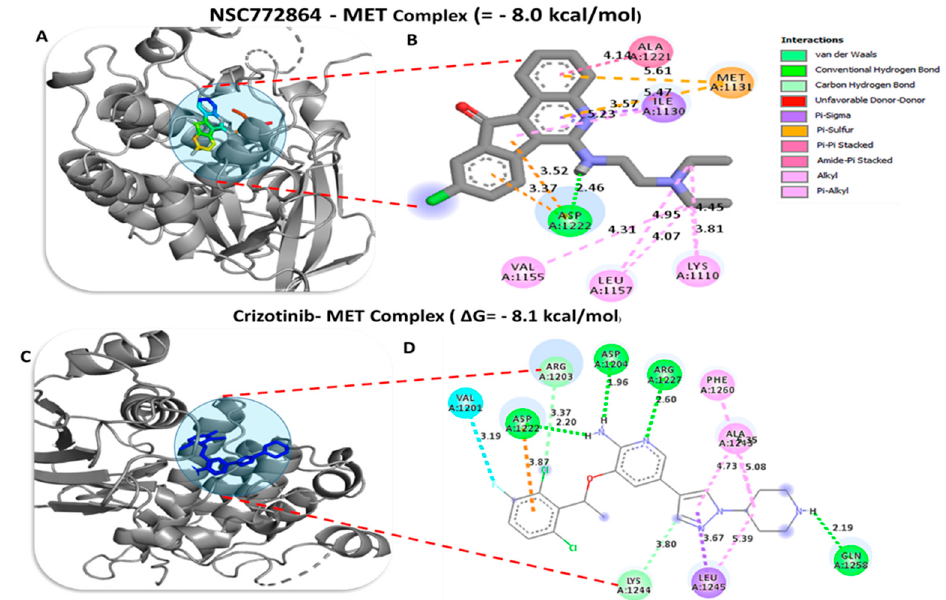
Figure 12. Docking profiles of c-Met with NSC772864 and standard inhibitors. ( A , B ) NSC772864 bound with c-Met with Gibbs’ free energy ( Δ G) of − 8.0 kcal/mol. ( C , D ) Binding of crizotinib with c-Met showed a slightly higher affinity of Δ G = − 8.1 kcal/mol compared to NSC772864. Table 3 gives binding energies of ligand–receptor interactions, including different types of interactions and the amino acid residues involved. Table 3. NSC772864 and standard drug comparative docking profiles against c-Met.